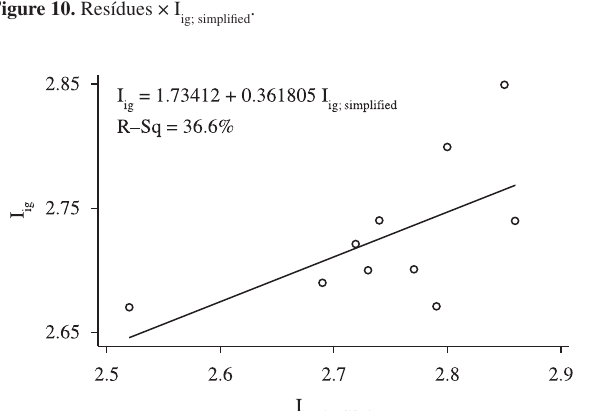
Figure 10. Resídues × I